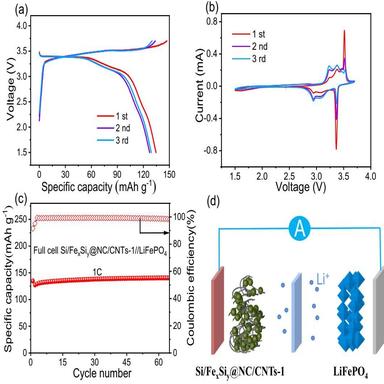
The electrochemical performance of Si/FexSiy@NC/CNTs-1//LiFePO4 full cell: (a) Charge-discharge curve of the first three cycles; (b) CV curves of the first three cycles; (c) Cycle performance at 1C; (d) Full cell model.